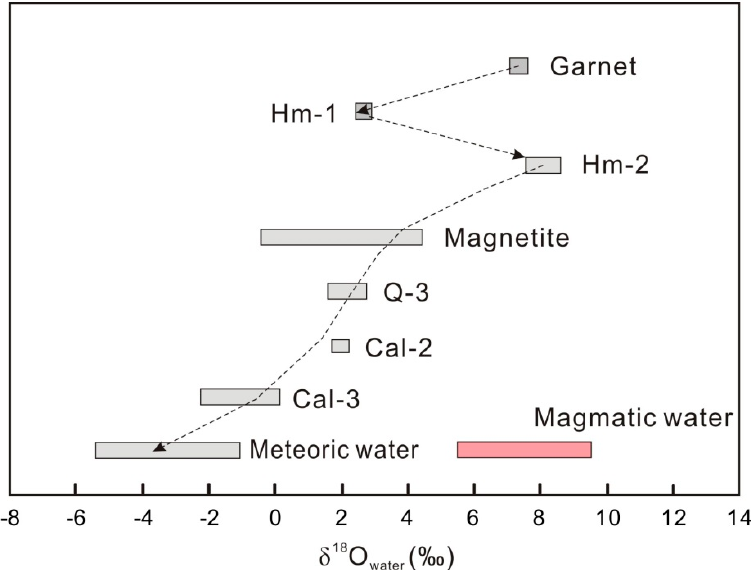
Figure 4. Oxygen isotope compositions ( δ 18 O water ) of the fluids in equilibrium with major minerals in the Taochong deposit. The magmatic field is according to Barnes [1,2]. The meteoric water field of the study area is according to Zhang [41] and Zhou and Yue [42]. The Y axis is the paragenetic sequence of the minerals as shown in figure 3I.